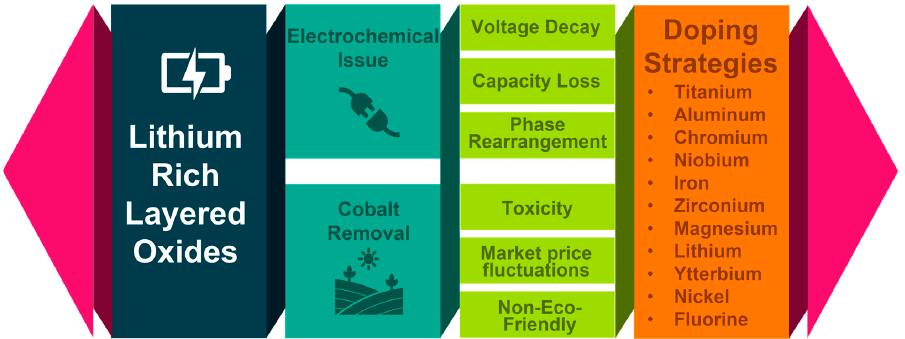
Figure 1. Schematic diagram of topic discussed in this review.